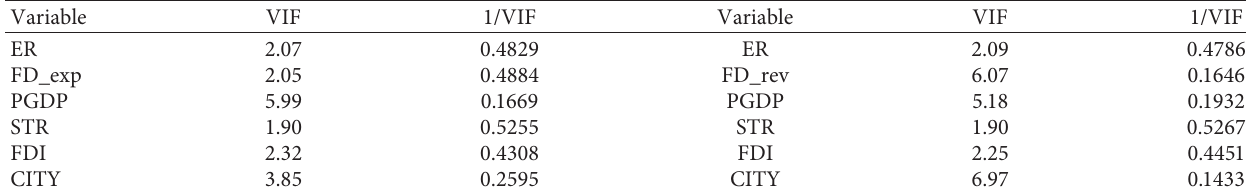
Table 2: Multicollinearity test.